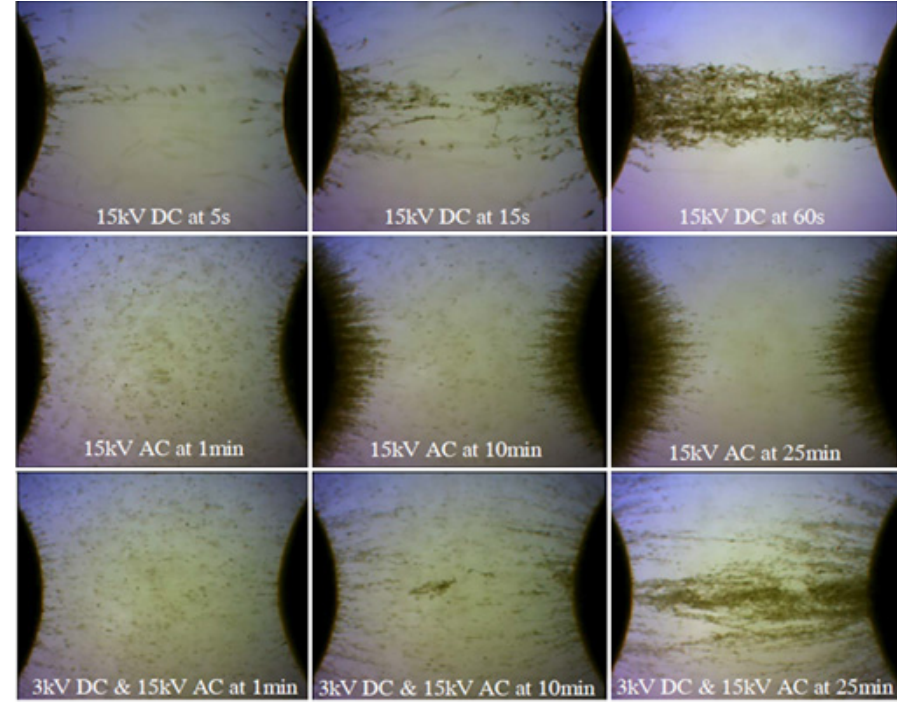
Figure 25. Optical microscopic images for bridging under influence of DC, AC and DC biased AC tests [52].